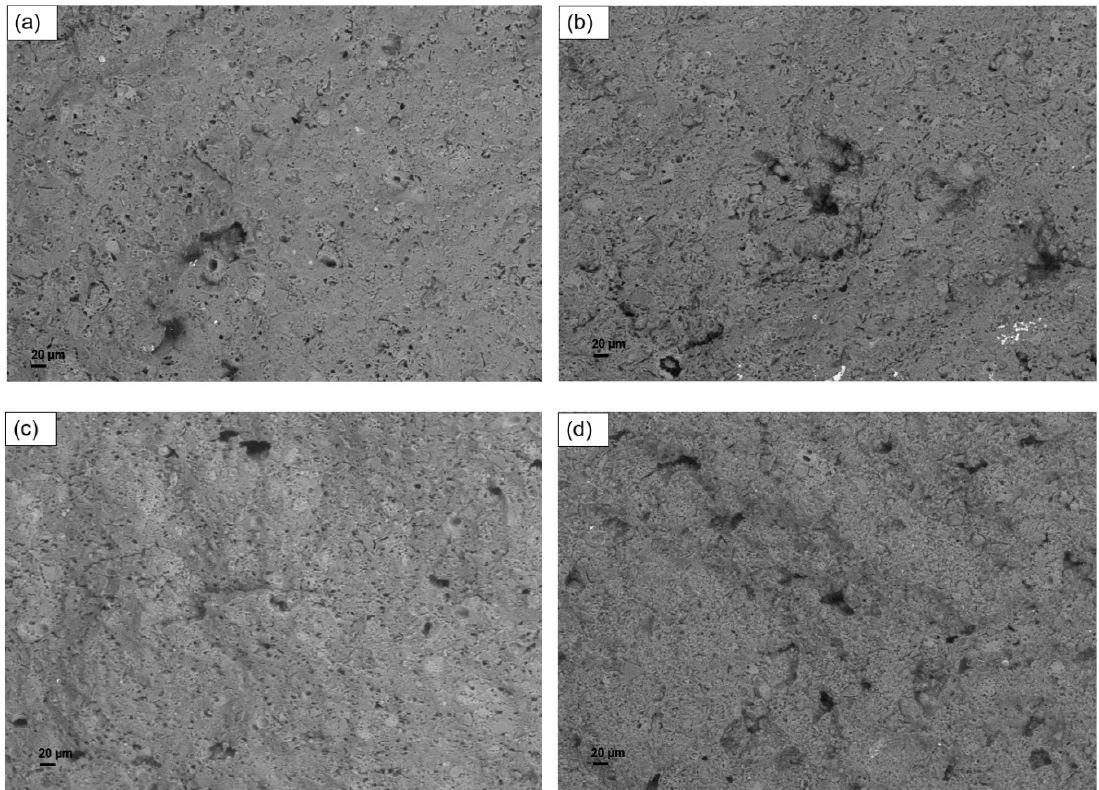
Figure 6. SEM micrographs of annealed samples: ( a ) G-0; ( b ) G-S5; ( c ) G-T5; ( d ) G-L5.